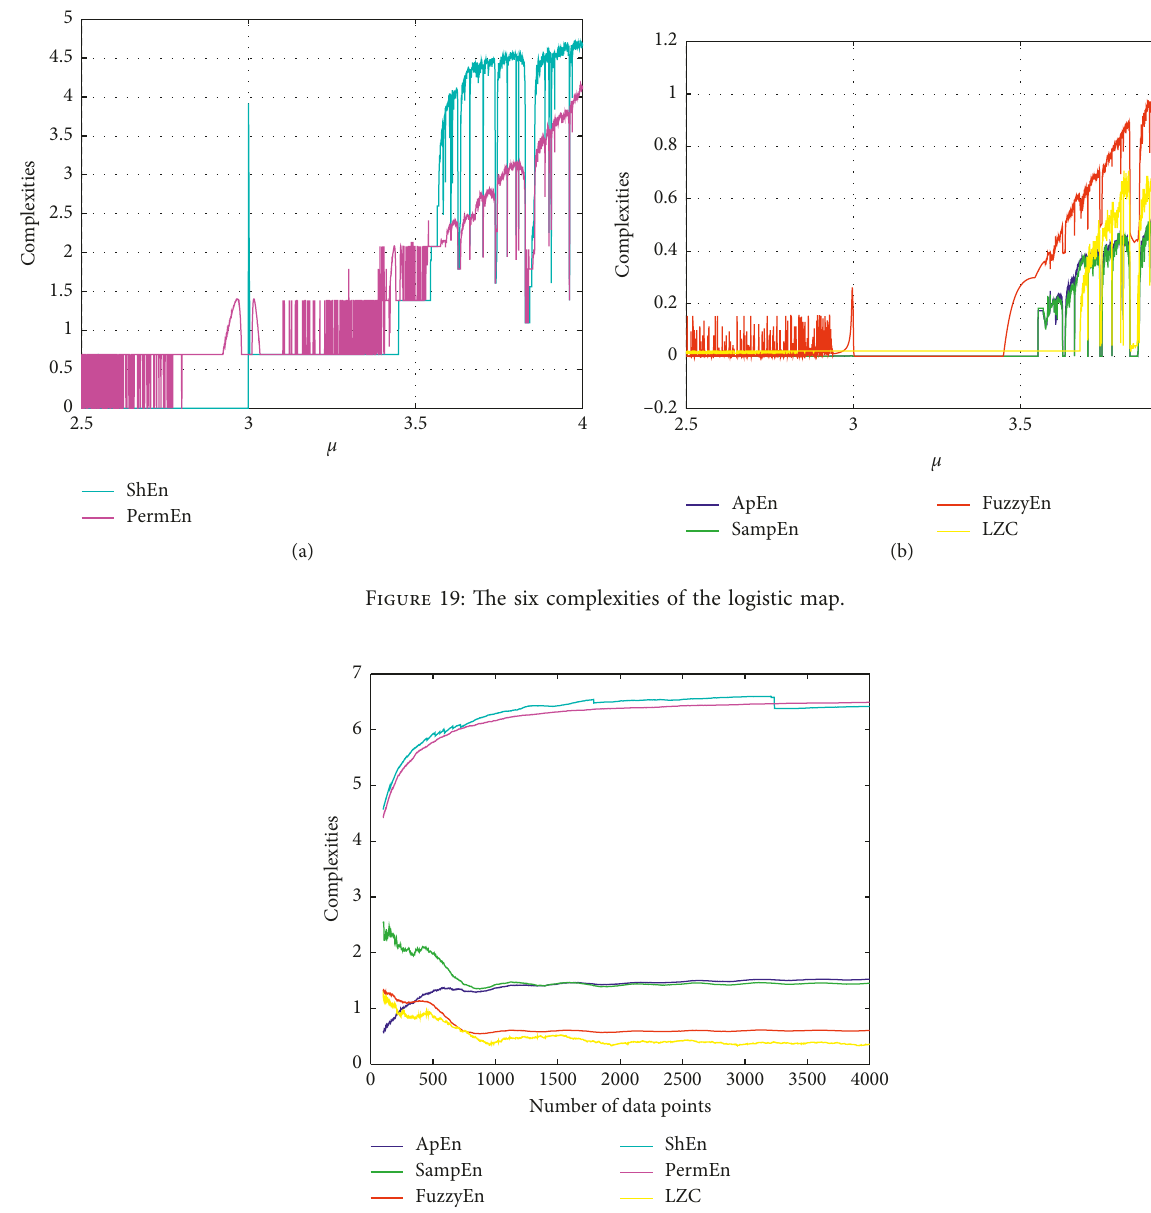
Figure 20: The curves of six complexities versus data length.